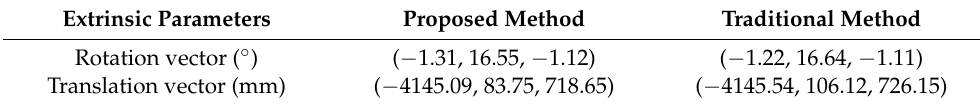
Table 5. Extrinsic parameters obtained with the proposed and traditional